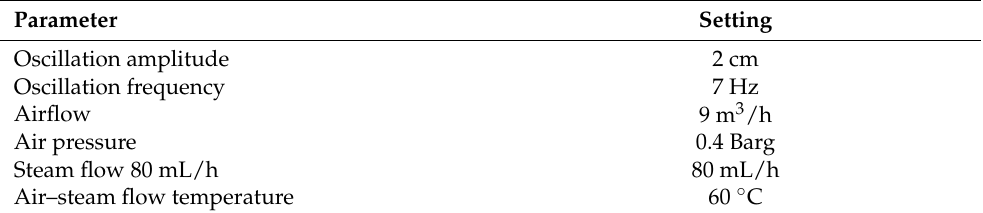
Figure 3. Scheme and picture of the bench scale vibro-fluidized bed detoxifier. Table 1. Optimized parameters for the vibro-fluidized bed reactor.